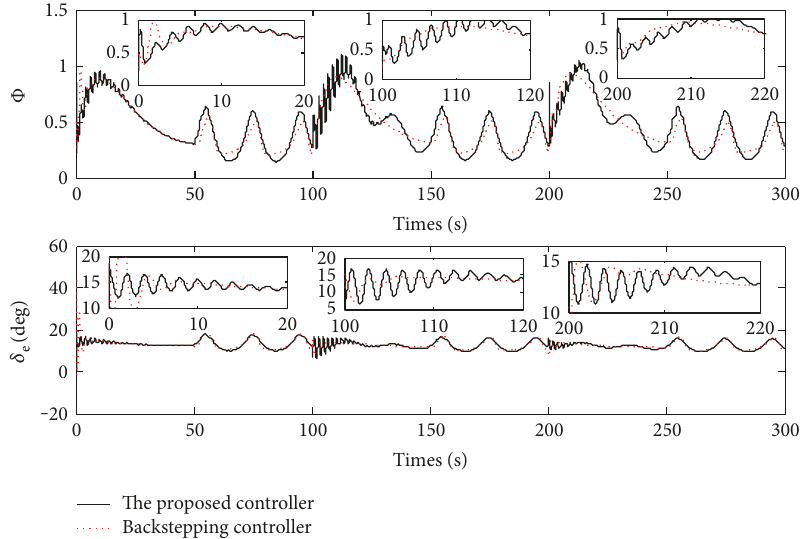
Figure 11: The control